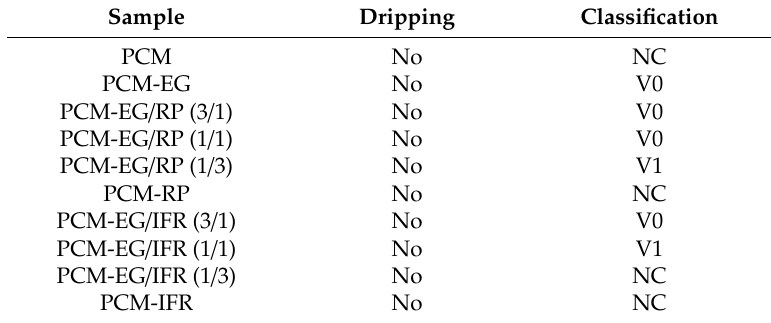
Table 2. Vertical burning results of di ff erent SSPCMs (acrylic resin / flame retardant = 10 / 5).